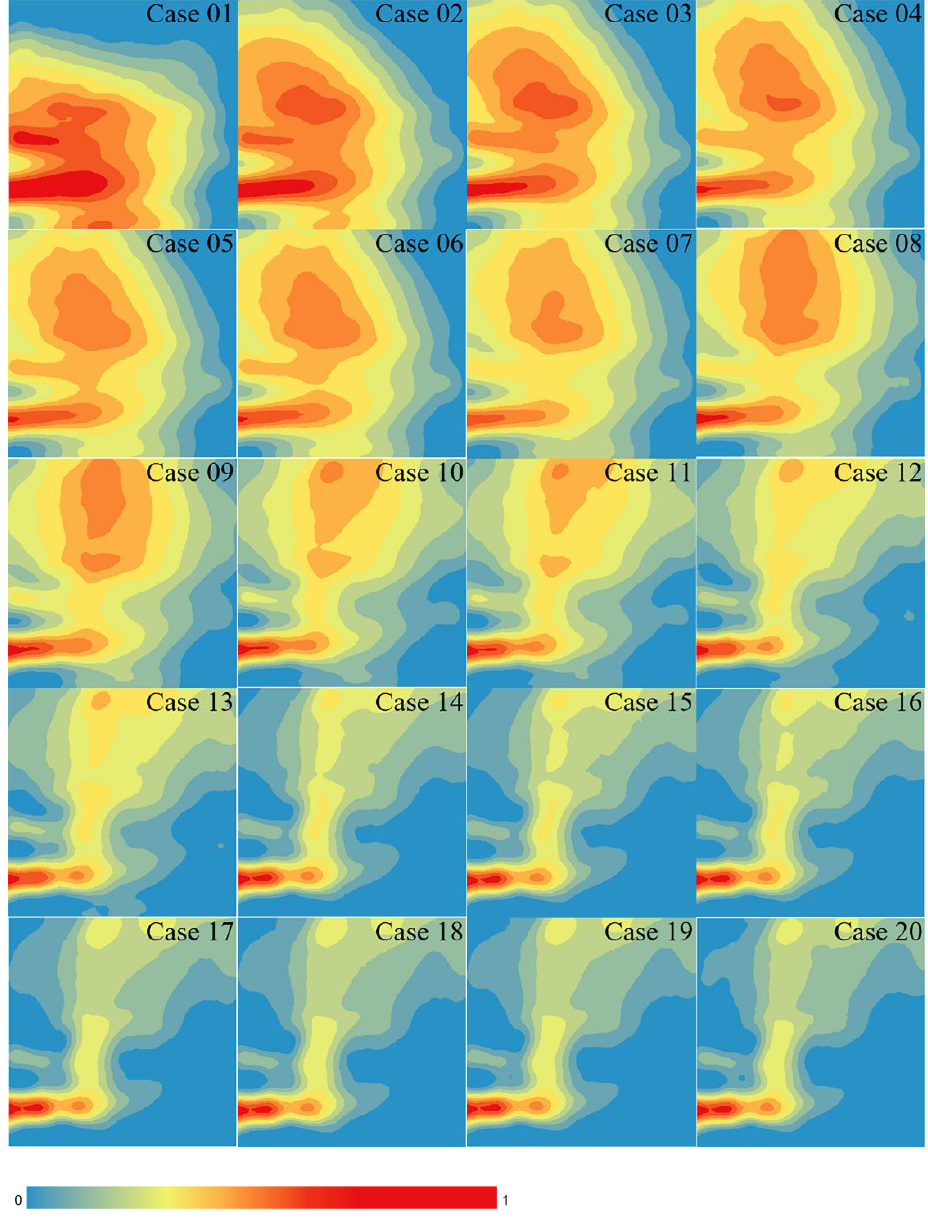
Figure 4. The normalized concentration field of the central plane under different conditions obtained by the MGGP model.